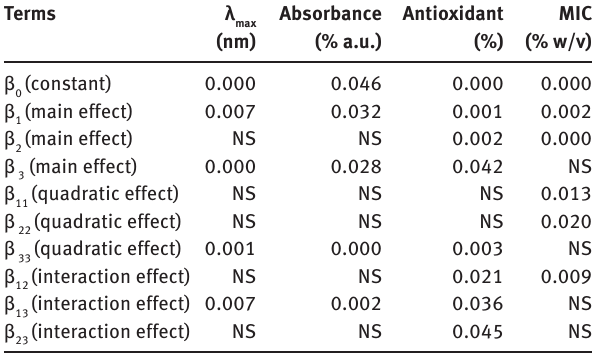
Table 3: The significance probability (p-value) of regression coefficients for the final reduced